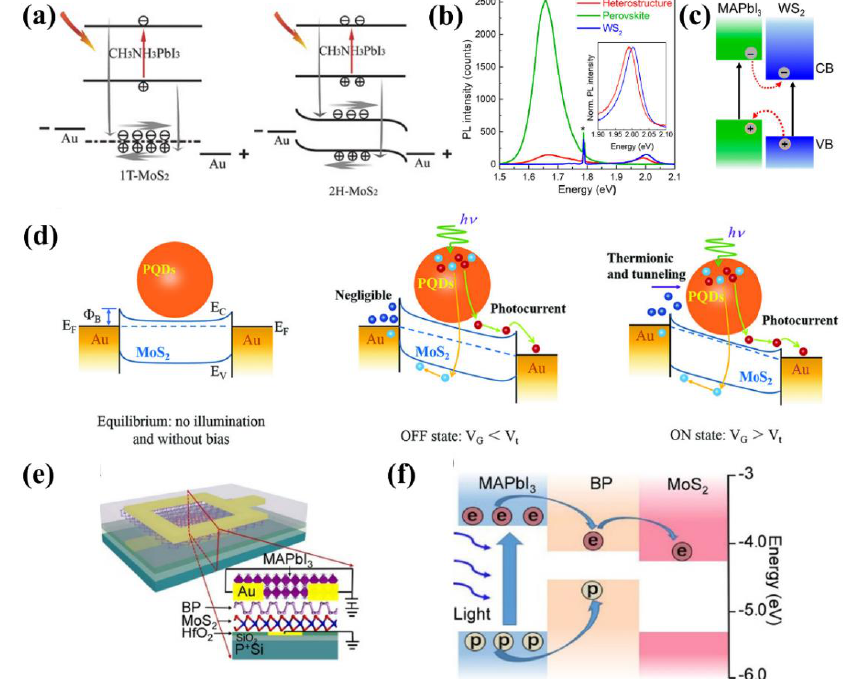
Figure 9. ( a ) Charge transfer mechanism of 1T-MoS 2 /MAPbI 3 and 2H-MoS 2 /MAPbI 3 photodetectors. ( b ) PL spectra of the fabricated heterostructure, isolated perovskite, and WS 2 . ( c ) Schematic illustration of type II band alignment and charge transfer at the MAPbI 3 /WS 2 heterostructure. ( d ) Schematic